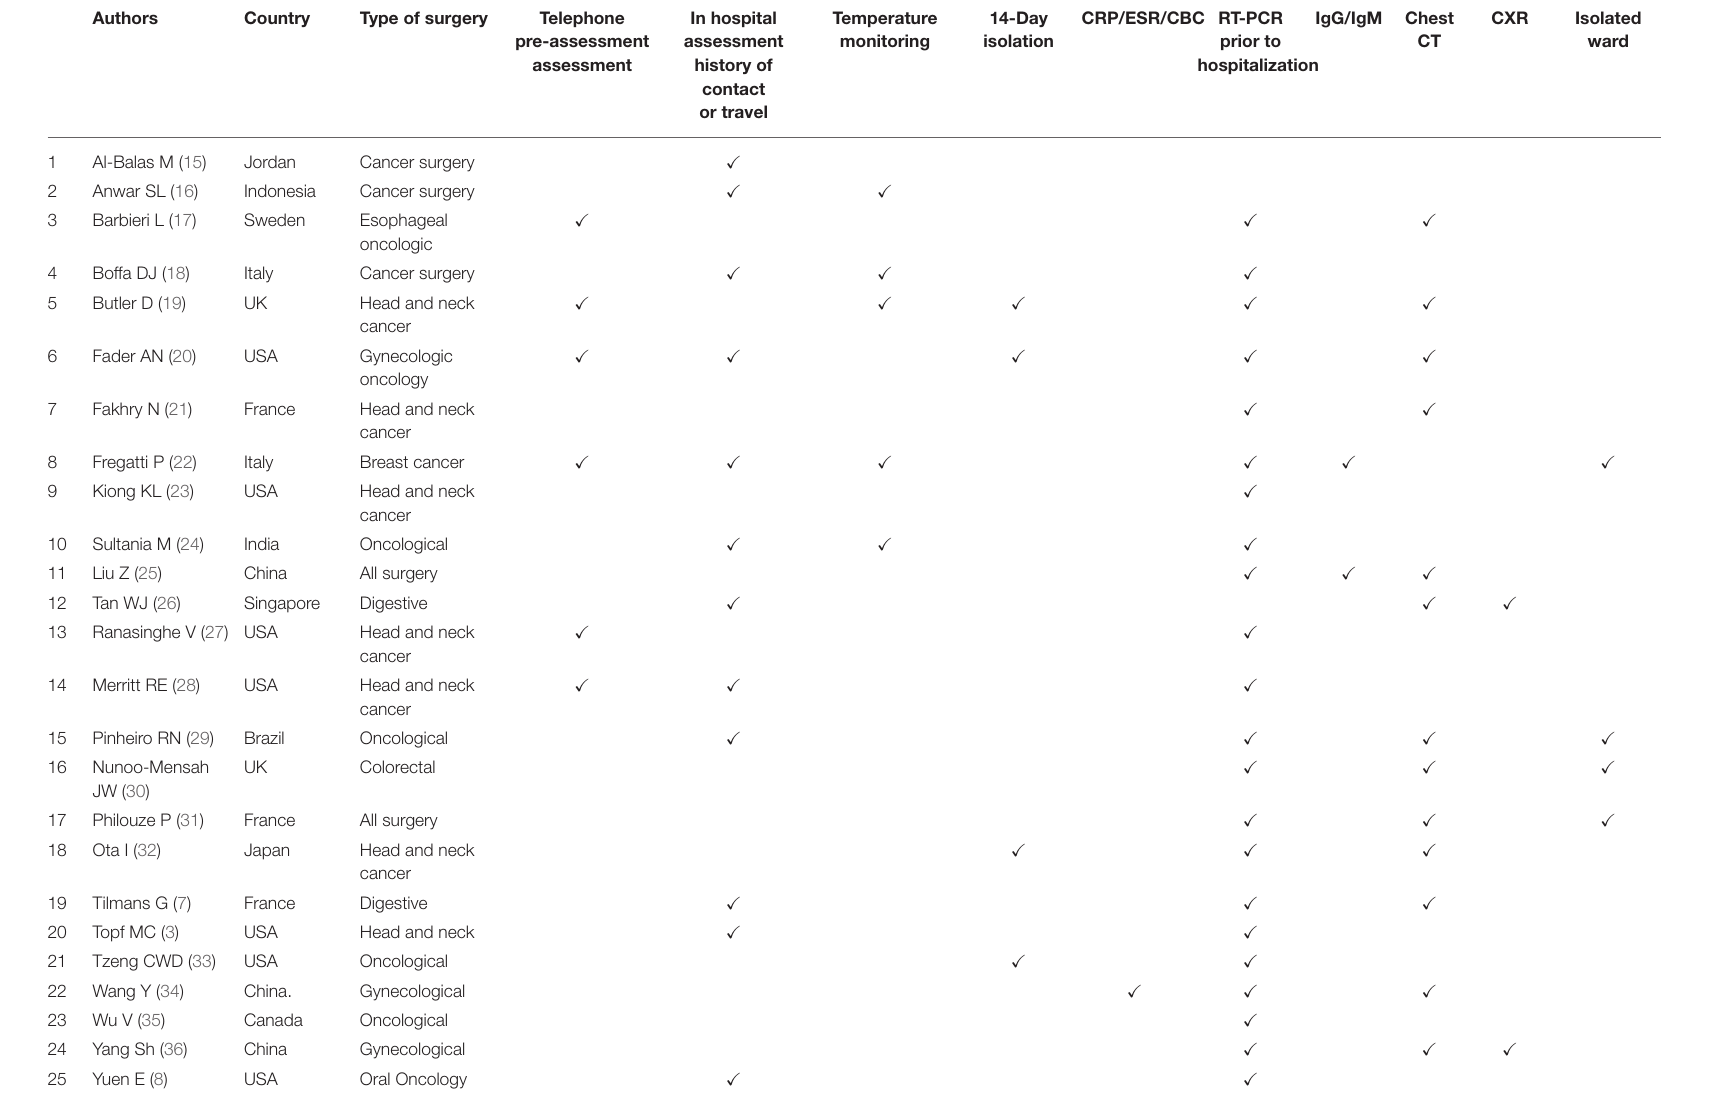
TABLE 2 | The type of surgeries and the summary of triage